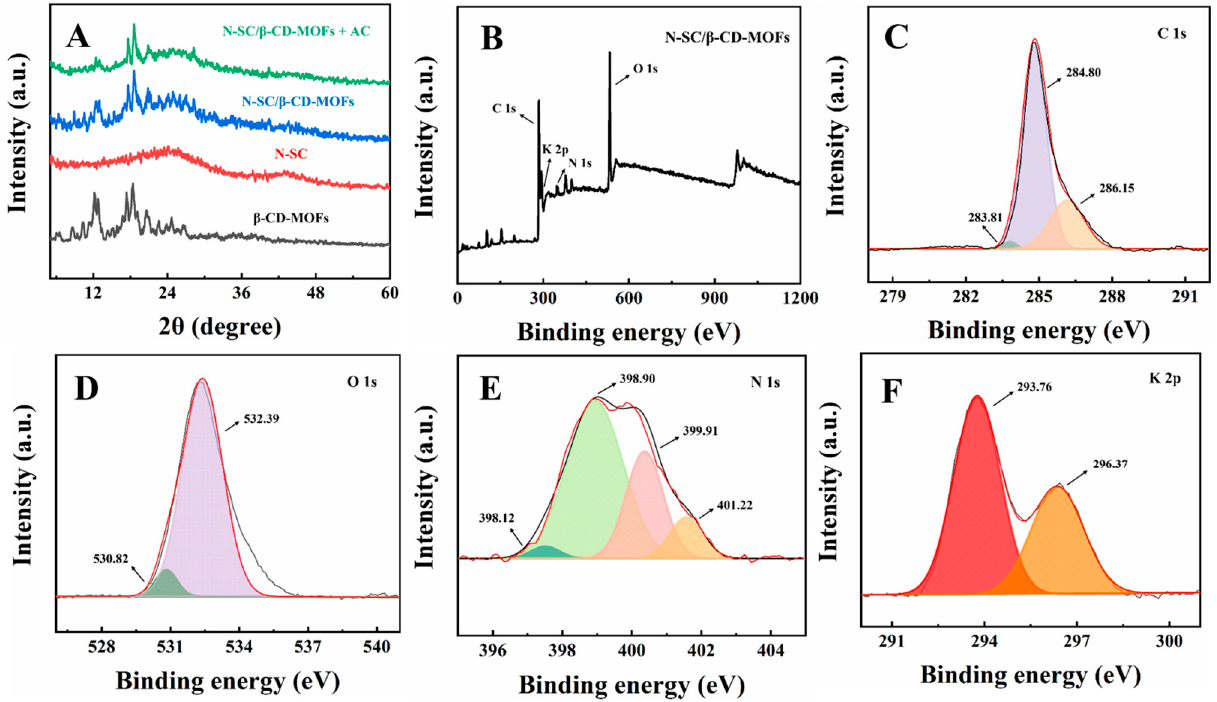
Figure 2. XRD pattern ( A ), Full-scan XPS spectra ( B ), and high-resolution spectrum of C 1 s ( C ), O 1 s ( D ), N 1 s ( E ), and K 2 p ( F ) of N-SC/ β